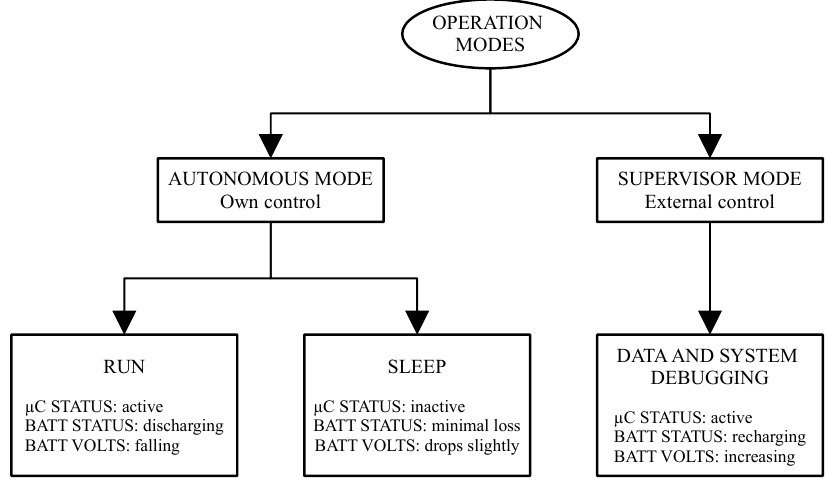
Figure 3. Diagram of the modes, states, and phases of operation existing in the sensor node.